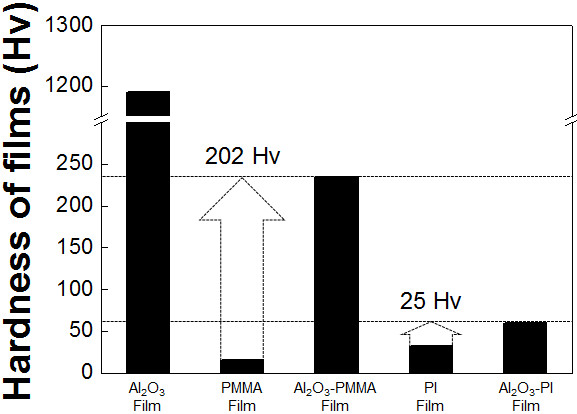
The hardness results of PMMA, PI, Al2O3, Al2O3-PI, and Al2O3-PMMA films.